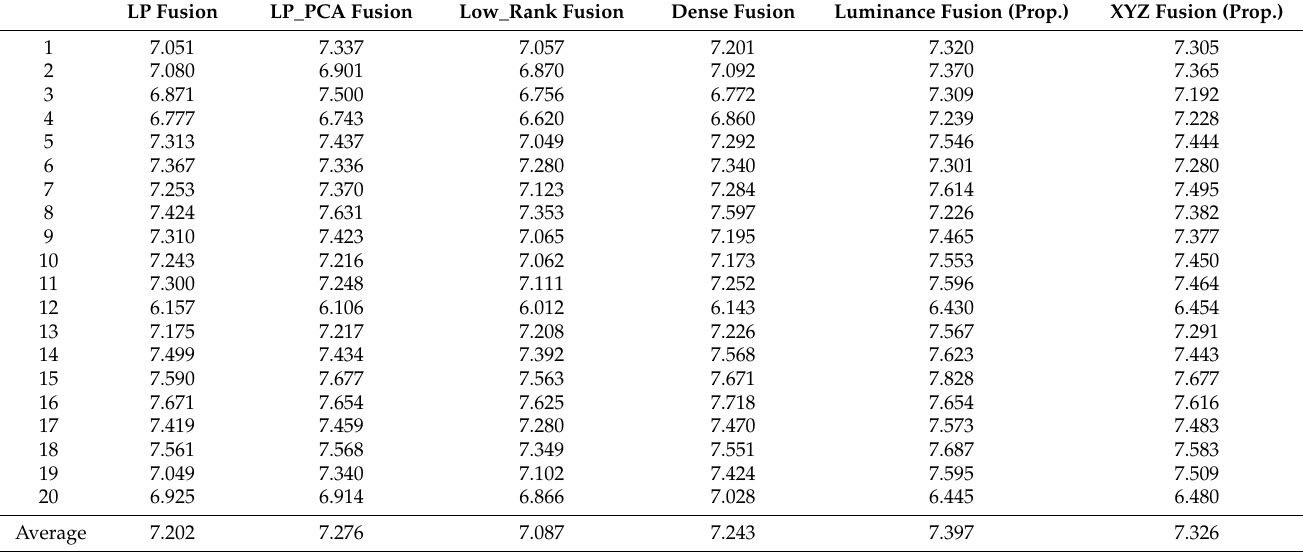
Table 5. Comparison of the Entropy metrics.